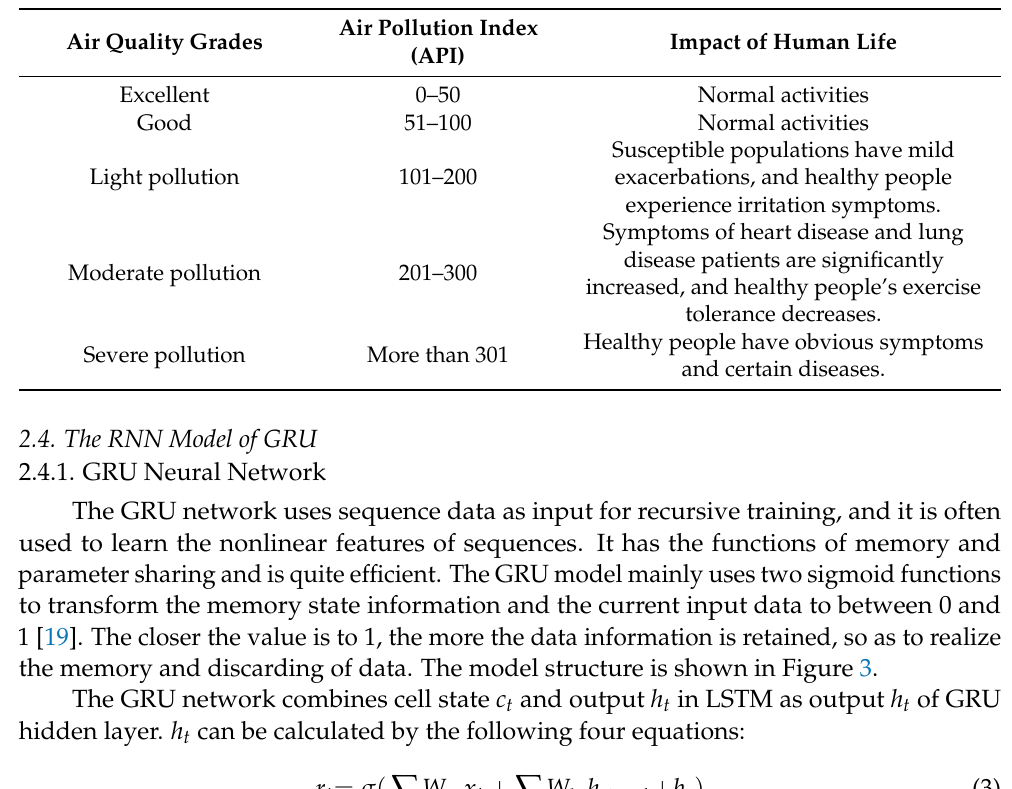
Table 3. Air quality grades and human activities